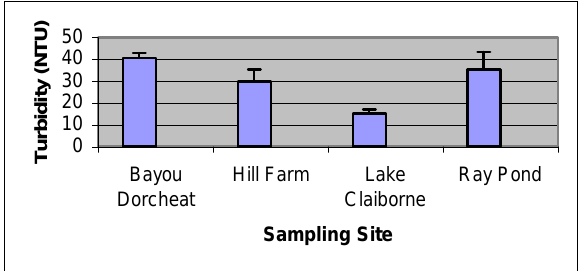
Figure 5: Mean values of turbidity (NTU), (n=15) at each sampling site.